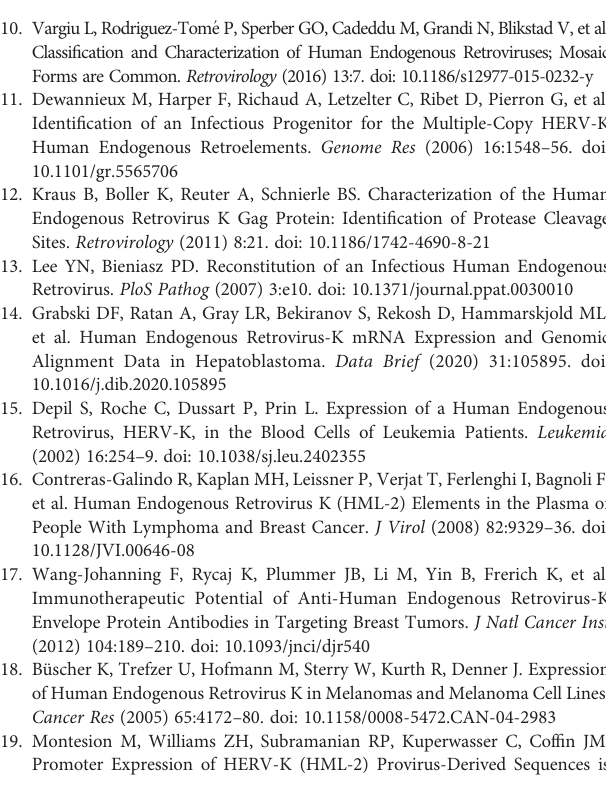
tumor samples. (A) Comparison of BRCA1 wild-type ductal primary breast tumor and MCF10A; (B) comparison of TNBC and MCF10A tissues. Supplementary Figure S4 | Heatmap of 76NF2V and MCF10A cells in dataset GSE96860. MCF denotes MCF10A cells, and X76NF2V is 76NF2V cells. Supplementary Figure S5 | Heatmap of tumor tissue and normal control tissue from healthy donors. (A) ER+ BCa versus control tissue in dataset GSE45419; (B) HER2+ BCa versus control tissue in dataset GSE45419; (C) TNBC versus control tissue in dataset GSE45419; (D) HER2+ BCa versus control tissue in dataset GSE52194; E: TNBC versus control tissue in dataset GSE52194. In all legends in each cluster, N denotes normal tissue controls, and C denotes tumor tissues. Supplementary Figure S6 | Heatmap of tumor tissue (ER+) and adjacent normal tissue in dataset GSE58135. In all legends in each cluster, N denotes adjacent normal tissues, and C denotes tumor samples. Supplementary Figure S7 | Heatmap of tumor tissue (TNBC) and the adjacent normal tissue in dataset GSE58135. In all legends in each cluster, N denotes the adjacent normal tissues, and C denotes tumor samples. Supplementary Figure S8 | Heatmap of tumor tissue and adjacent normal tissue in dataset GSE103001. In the legends in each cluster, N denotes adjacent normal tissues, and C denotes tumor samples. Supplementary Figure S9 | Heatmap of tumor tissue and adjacent normal tissue in datasets GSE133998 and GSE183947. In all legends in each cluster, N denotes adjacent normal tissue, and C denotes tumor tissue. Supplementary Figure S10 | Heatmap of tumor tissue and adjacent normal tissue featuring metastatis in dataset GSE183947. TumorM indicates the tumor tissue with metastasis, TumorP indicates the tumor tissue without metastasis, NormalM indicates adjacent normal tissue with metastasis, and NormalP indicates adjacent normal tissue without